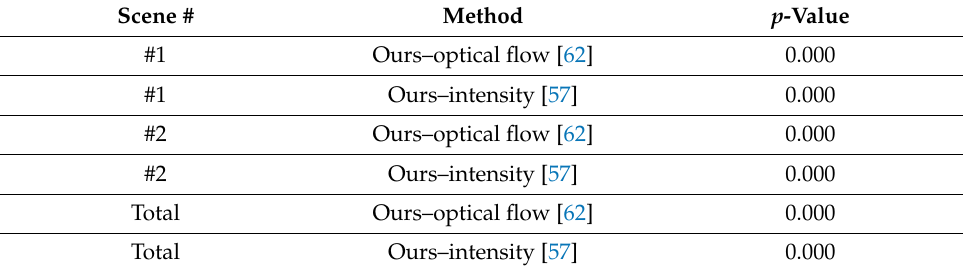
Table 7. Analysis of error statistics in environment with motion noise.